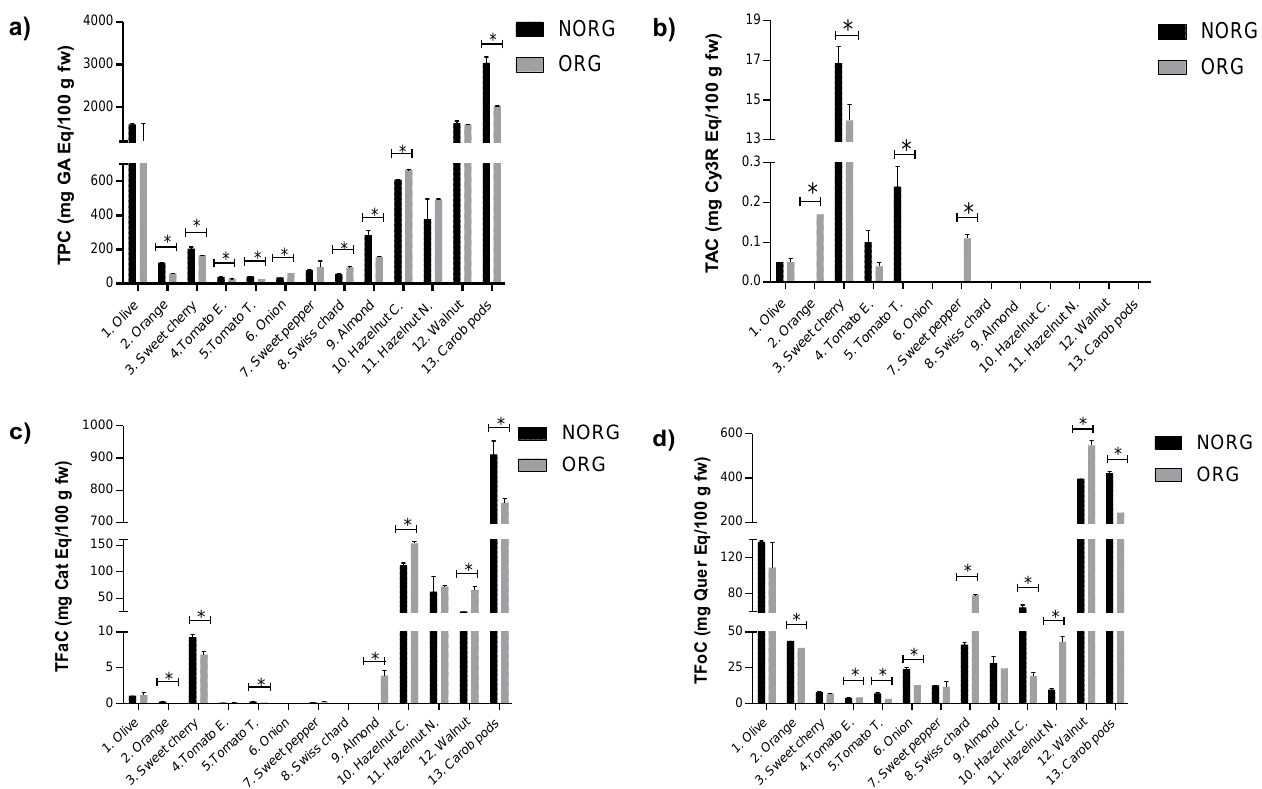
Figure 1. Phenolic compounds content in organic and non-organic plant-based foods: ( a ) Total phenolic content. ( b ) Total anthocyanins content. ( c ) Total flavan-3-ols content. ( d ) Total flavonols content. Samples analyzed per plant-based food ( n = 3), analytical replicates per samples ( qc = 3). Values are expressed as mean ± standard deviation (SD). * Statistical difference between farming practices by Student’s t -test ( p < 0.05). Abbreviations: Cy3R, cyanidin-3- O -rutinoside; Eq, equivalent; GA, gallic acid; Hazelnut C, hazelnut cv. Castanyera; Hazelnut N, hazelnut cv. Negreta; NORG, non-organic farming; ORG, organic farming; TAC, total anthocyanins content; TFaC, total flavan-3-ols content; TFoC, total flavonols content; Tomato E, tomato cv. Ekstasis; Tomato T, tomato cv. Tores; TPC, total phenolic content.